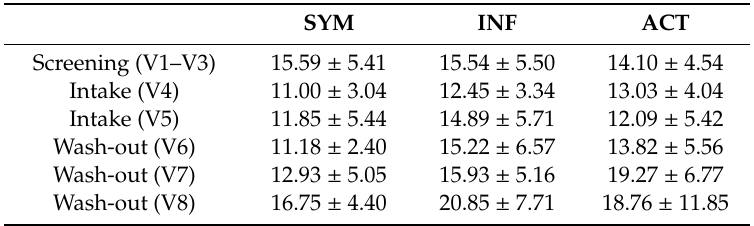
Table 3. Biofilm thickness (BT in µ m; mean ±